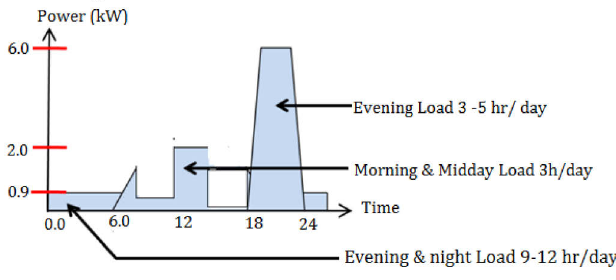
Figure 4: Typical Household Load Profile B. Electric Energy Consumption